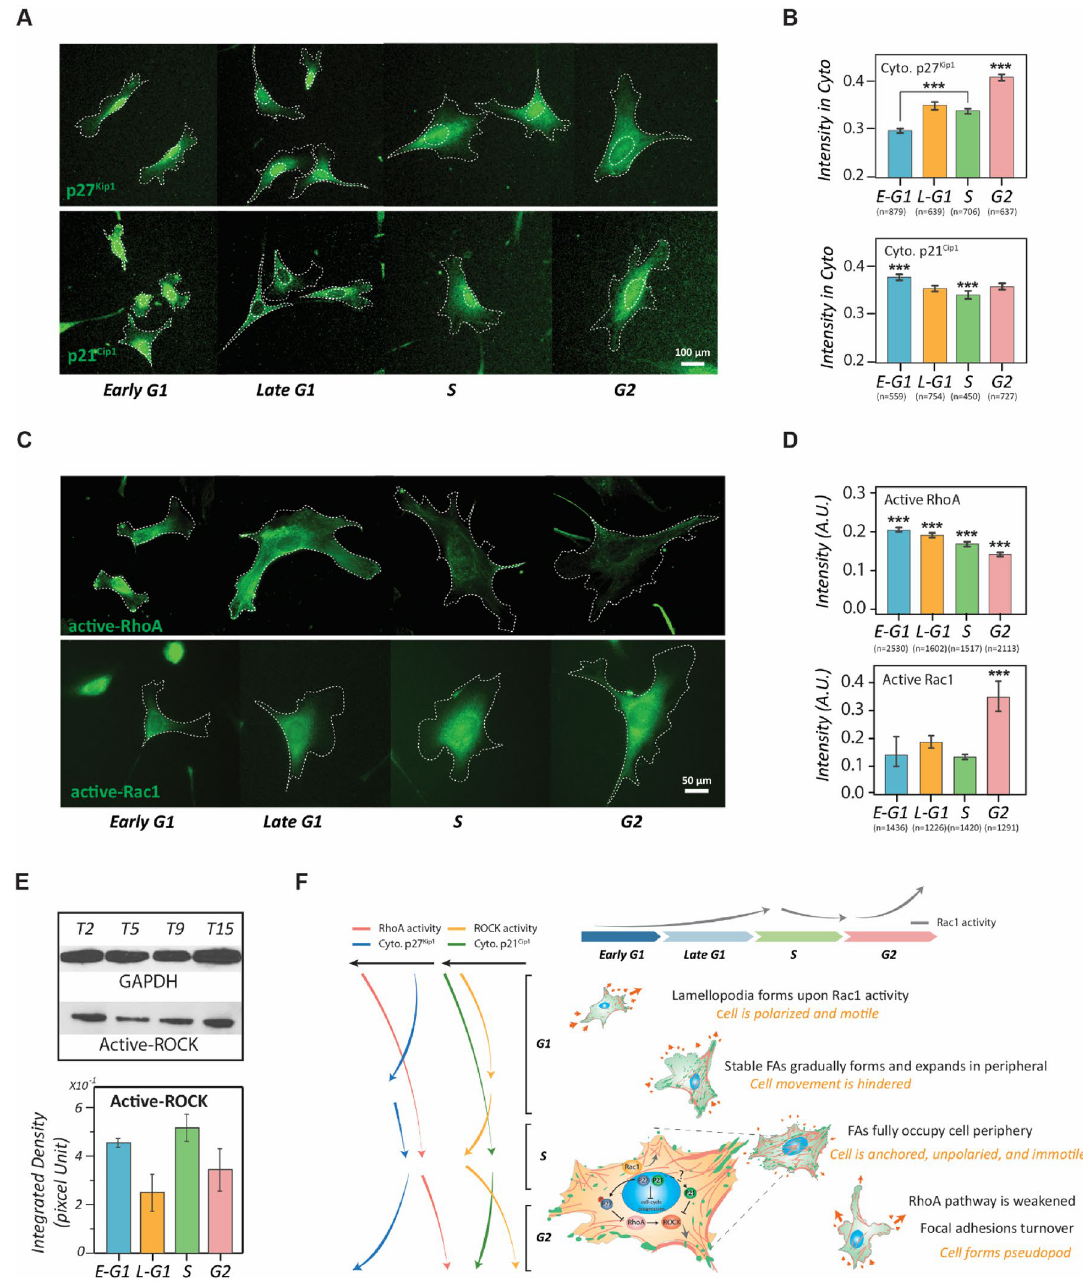
Figure 5. The involvement of cytoplasmic p27 Kip1 and p21 Cip1 in regulating the cell-cycle-dependent cell phenotype transitions. ( A ) Fluorescent images of p27 Kip1 and p21 Cip1 in each stage of the cell cycle phases. Dotted lines depict the boundaries of the cells and nuclei. Scale bar: 50 µm. ( B ) Bar plots showing the concentration profiles of the cytoplasmic p27 Kip1 (up) and p21 Cip1 (down) in different stages of the cell cycle phases. Error bars represent the SEM. ( C ) Immunostaining of active-RhoA and active-Rac1 in NIH 3T3 fibroblasts of each stage of the cell cycle phases. Dotted lines depict the boundaries of the cells. Scale bar: 50 µm. ( D ) Bar plots showing the activity profiles of active RhoA (up) and active Rac1 (down) in single cells of different cell cycle stages. ( E ) Western blot results of active ROCK in different cell cycle phases. Control: GAPDH. Error bars represent standard errors (n = 2). ( F ) Metaphorical landscape illustrating the migration phenotype transitions caused by Rho-GTPase and CDKIs pathways along with cell cycle progression. The magnified view of the S-phase cells shows the molecular interactions between CDKIs and RhoA pathways in the S phase. Data information: *** indicates that the group of data is statistically significant compared to other groups. The related statistical results of this figure are listed in Supplementary Tables 4 and